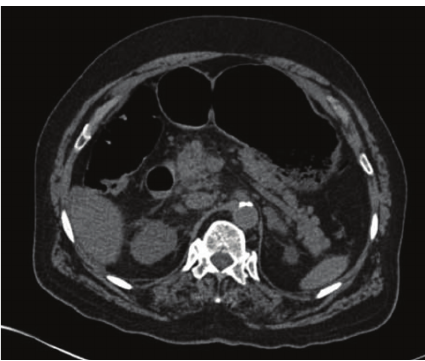
Figure 3: CT showing a calcified plaque at the origin of the celiac axis (Case 1).